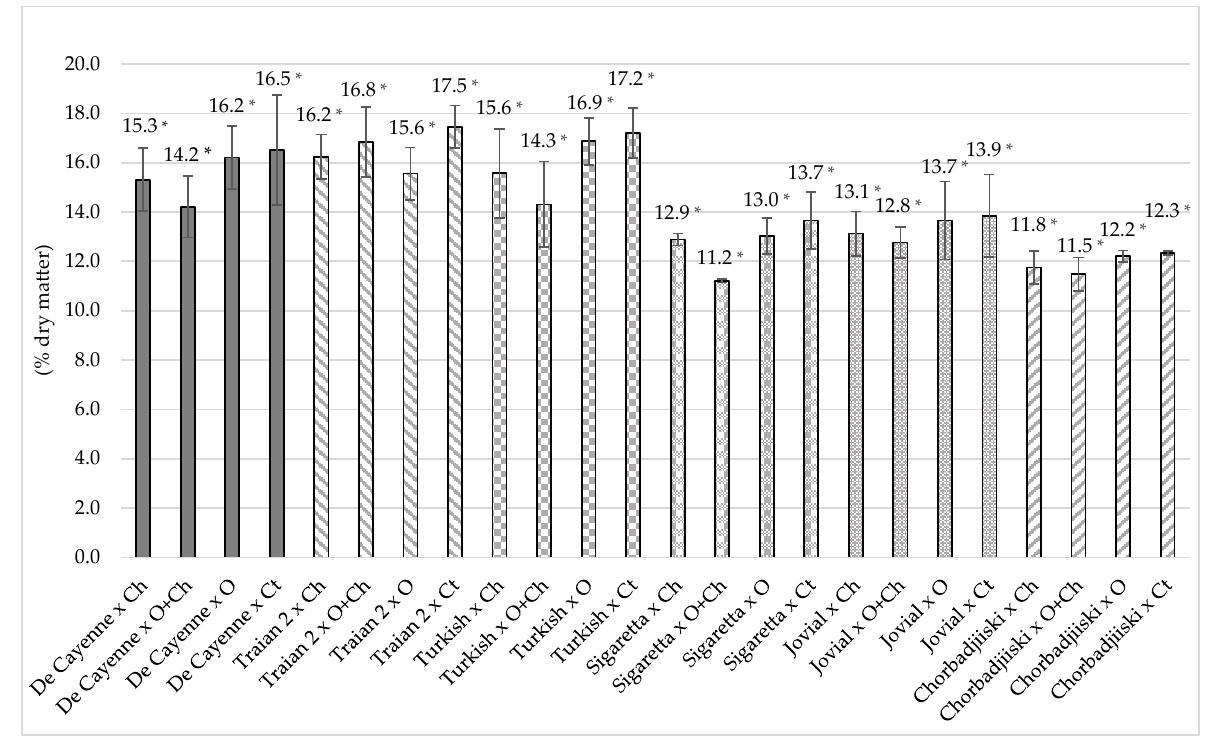
Figure 3. Dry matter content of samples influenced by interaction between cultivar and fertilization. Ch—Chemical; O + Ch—Organic + Chemical; O—Organic; Ct—Control. Along each line, values followed by different letters are significantly different according to the Tukey’s test at p ≤ 0.05; *—non-significant. Table 2. Biometric indicators and yield affected by cultivar and